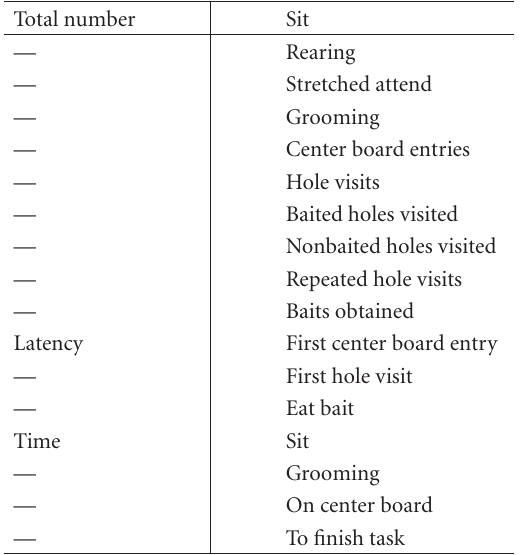
Table 1: Behavioral parameters measured in the modified hole